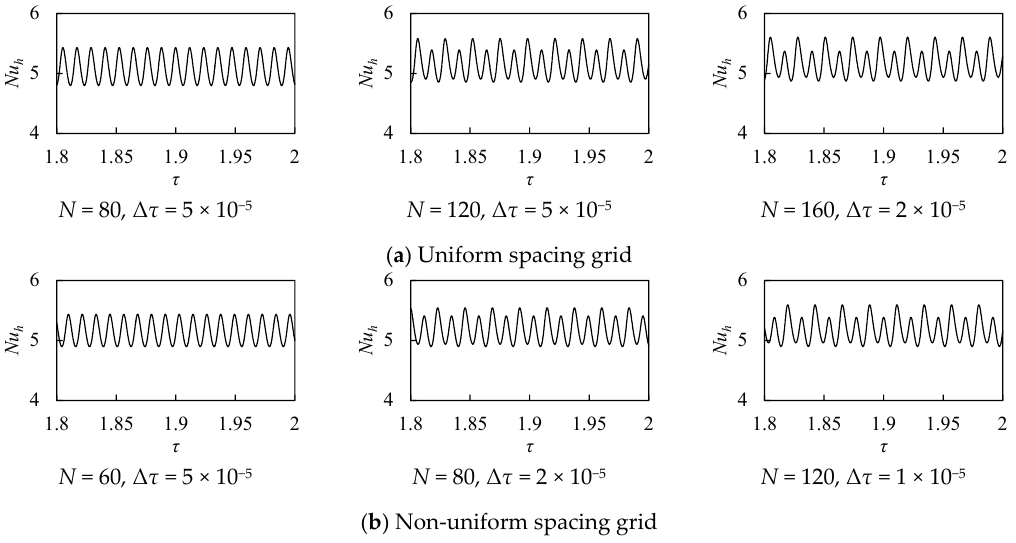
Figure 4. Time development of Nu h with uniform grids at Pr = 0.025, κ = 0.99, Ra = 5 × 10 5 , and Ha = 0.